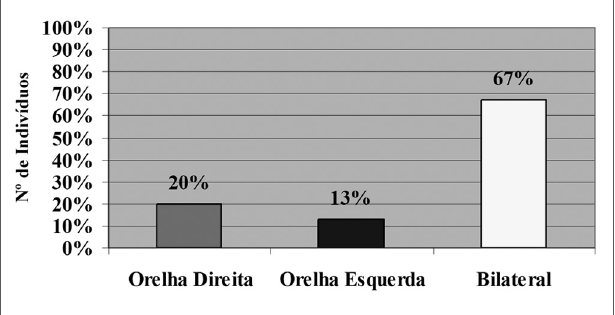
Figura 1. Resultados obtidos com relação à localização do zumbido nos indivíduos do grupo pesquisa (N=30).